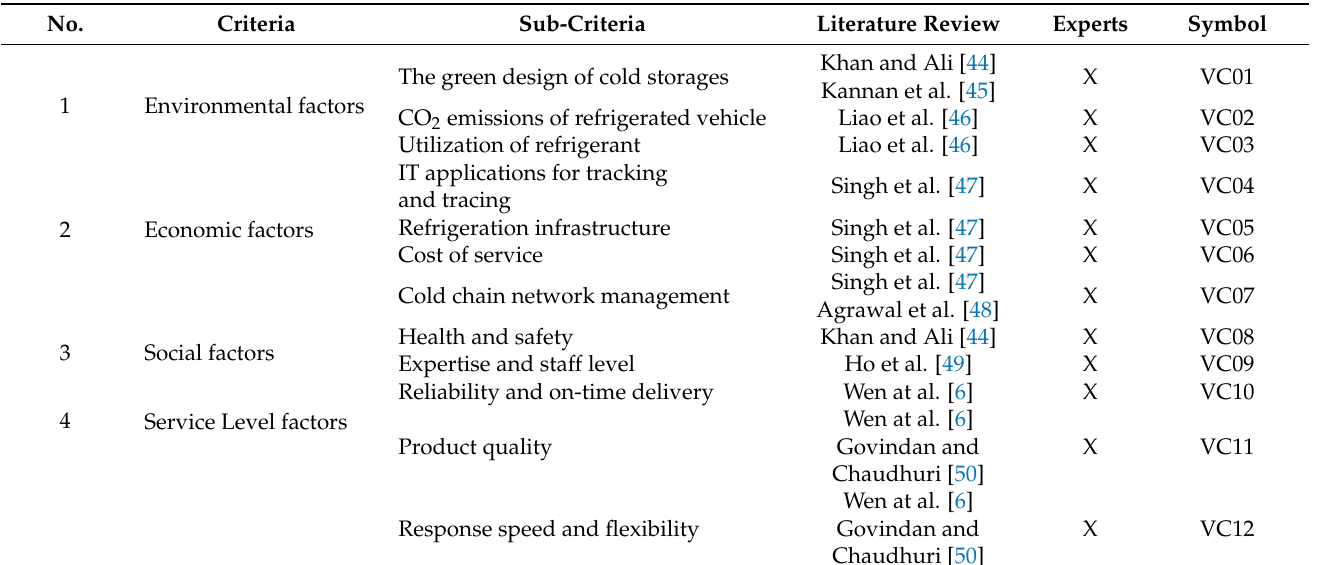
Table 1. List of criteria affecting the decision-making